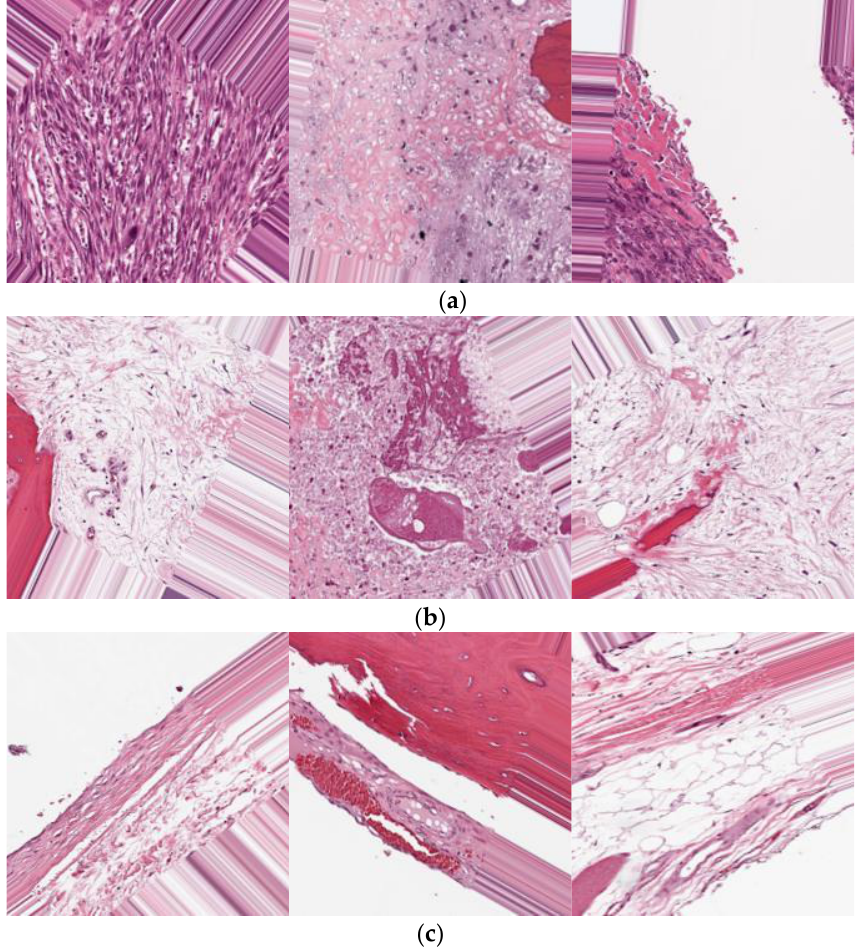
Figure 2. Data samples from each prediction class: ( a ) viable, ( b ) viable tumor, ( c ) non-tumor.